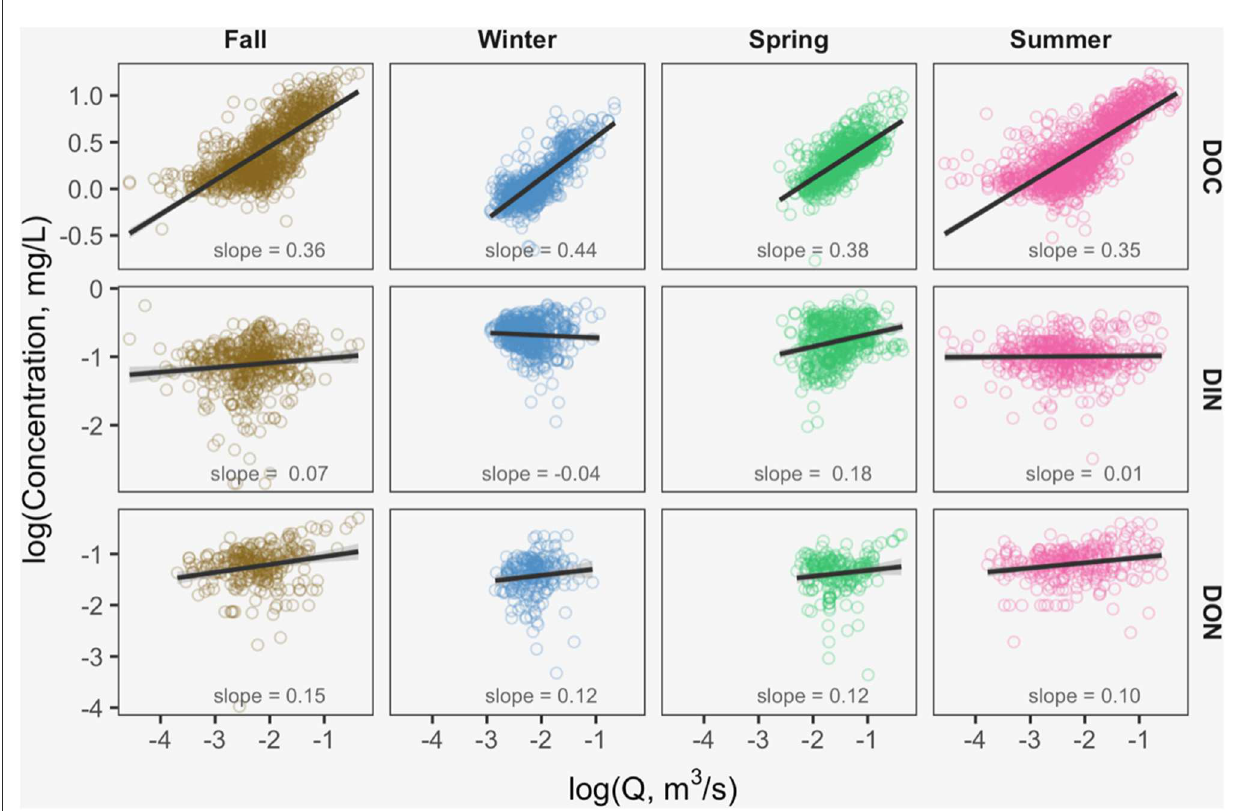
FIGURE2 Seasonal concentration-discharge (C-Q) behavior for log-transformed dissolved organic carbon (DOC), dissolved inorganic nitrogen (DIN), and dissolved organic nitrogen (DON) concentrations in mg/L vs. log-transformed Q in cubic meters per second (m 3 /s). Seasons are represented by color. The slope of the log C-log Q relationship is shown and describes the directionality of the relationship. Positive slopes indicate an enrichment response. Negative slopes indicate a dilution response. Slope values near zero indicate a constant